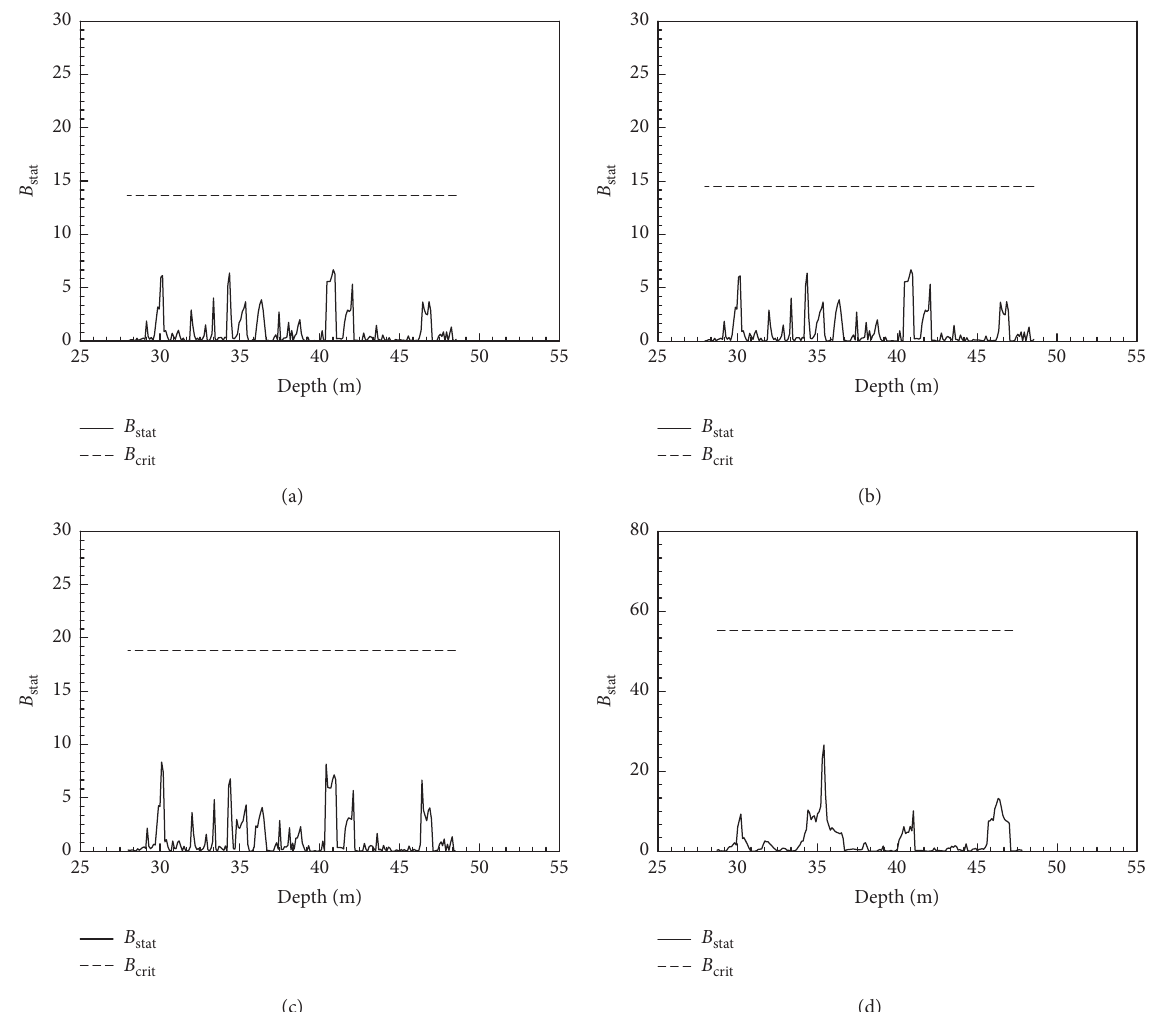
Figure 8: Validation of stationarity of CPT data for the medium silty clay layer. (a) M